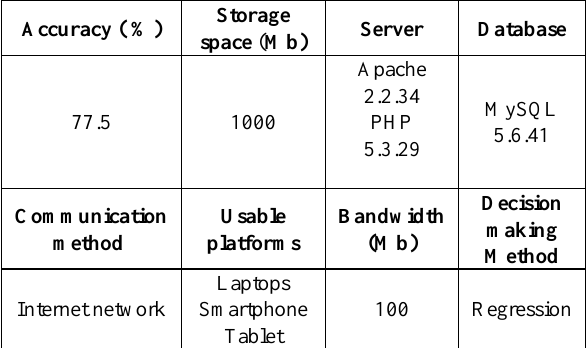
Table 1. Specifications of the proposed system